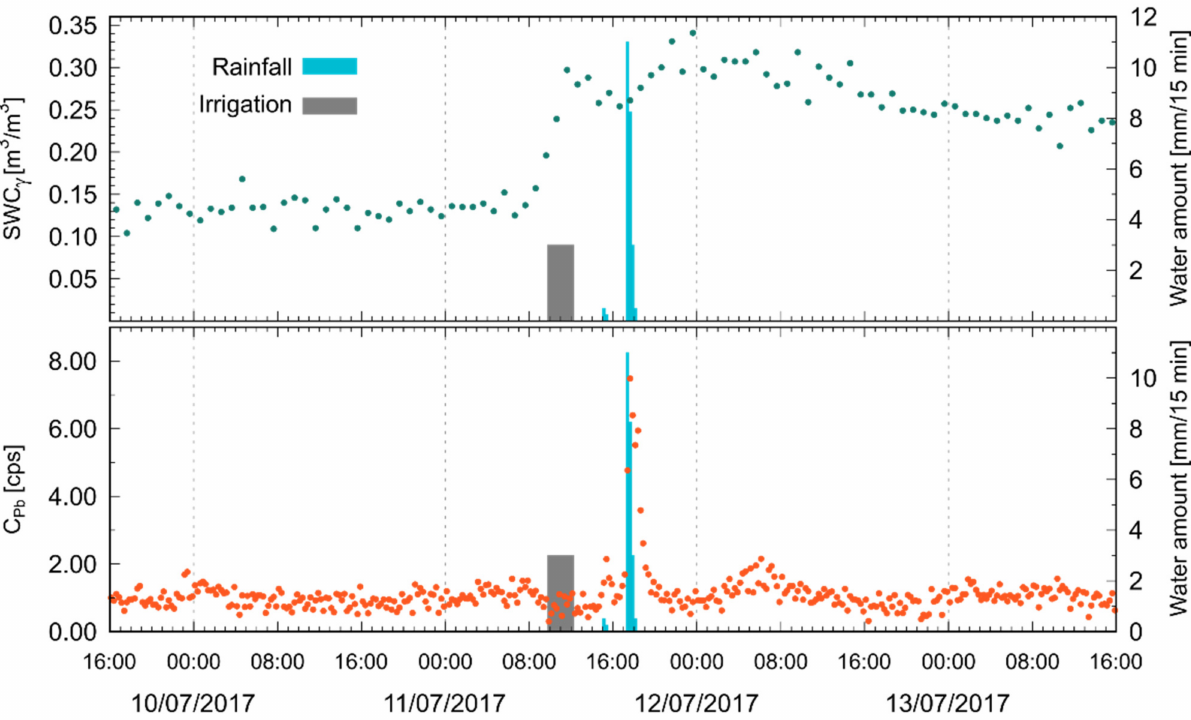
Figure 5. Temporal evolution of SWC γ and of C Pb from 09/07/2017 (16:00) to 13/07/2017 (16:00) together with the water amount of irrigation (gray bar) and rainfall (blue bars), modified after